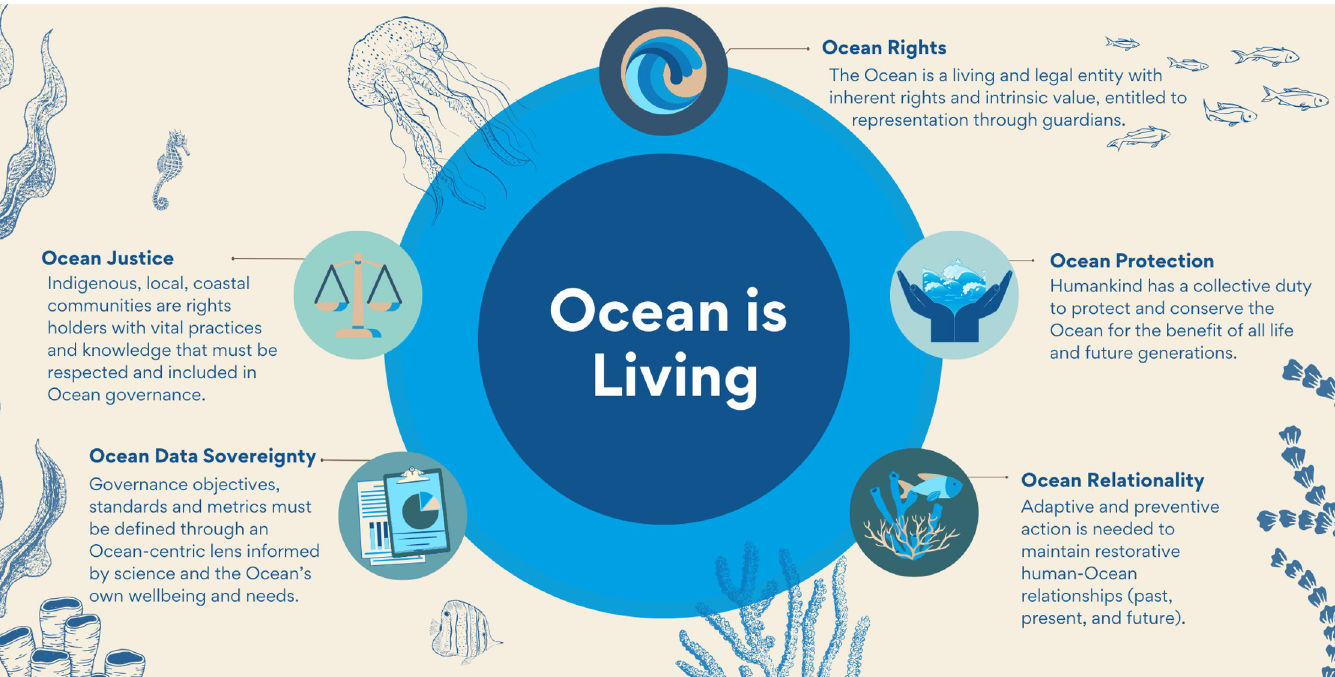
Fig 1. Ocean-centered principles to guide Ocean governance transformation. Interconnected relationships between Ocean-centered governance principles of justice, data sovereignty, rights, protection, and relationality rippling out from the key understanding that the Ocean is living. Transformation in Ocean governance requires action across all 5 principles. Created by Rachel Bustamante via